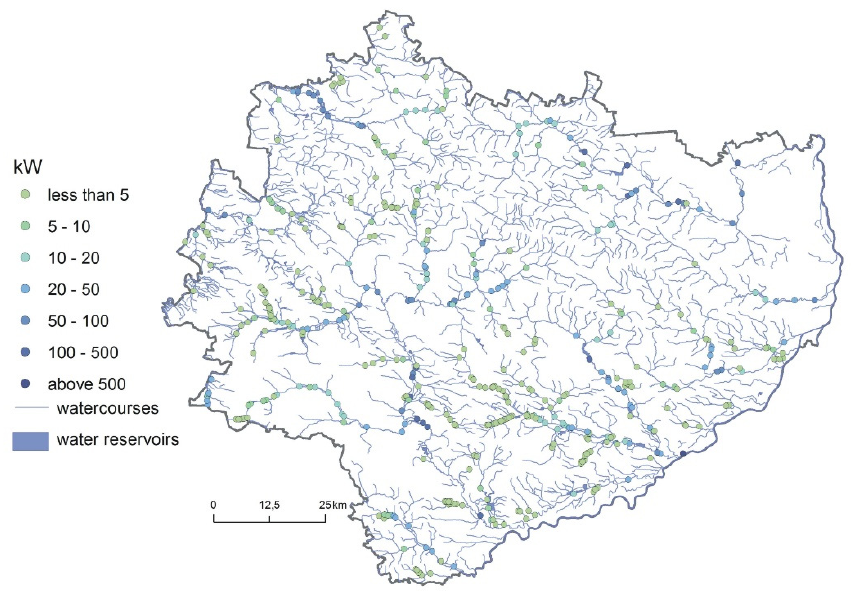
Figure 18. Localization of water dams and power of the potential hydropower plants in the Ś wi ę tokrzyskie voivodeship (own elaboration).